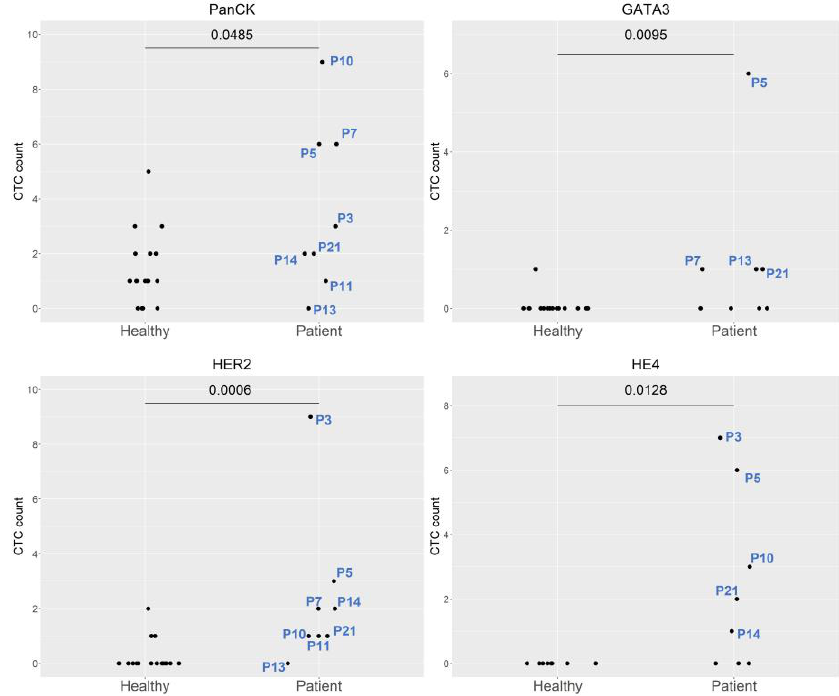
Figure 3. Comparison of the expression of different molecular markers between healthy controls and endometrial cancer patients. Abbreviations: P3, Patient 3; P5, Patient 5; P7, Patient 7; P10, Patient 10; P11, Patient 11; P13, Patient 13; P14, Patient 14; and P21, Patient 21. P10, diagnosed with stage IIIa endometroid carcinoma, exhibited peritoneal recurrence at the third follow-up, with re-expression of PanCK and GATA3. Initial expression of CD13 was observed. CD13 expression persisted throughout the first and second follow-ups (Figure